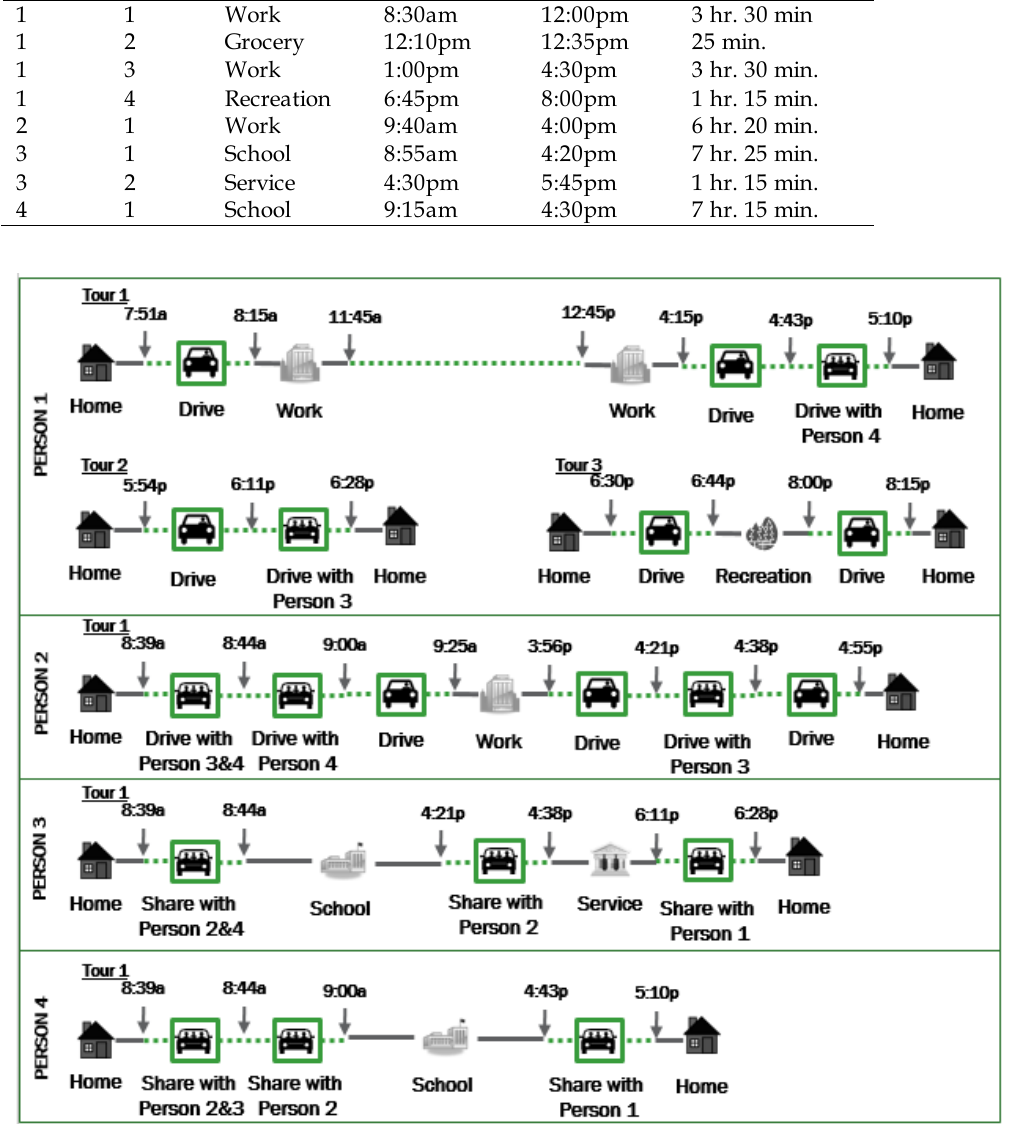
Figure 2. Modelled Schedule of Activities and Trips for Household with Dependents